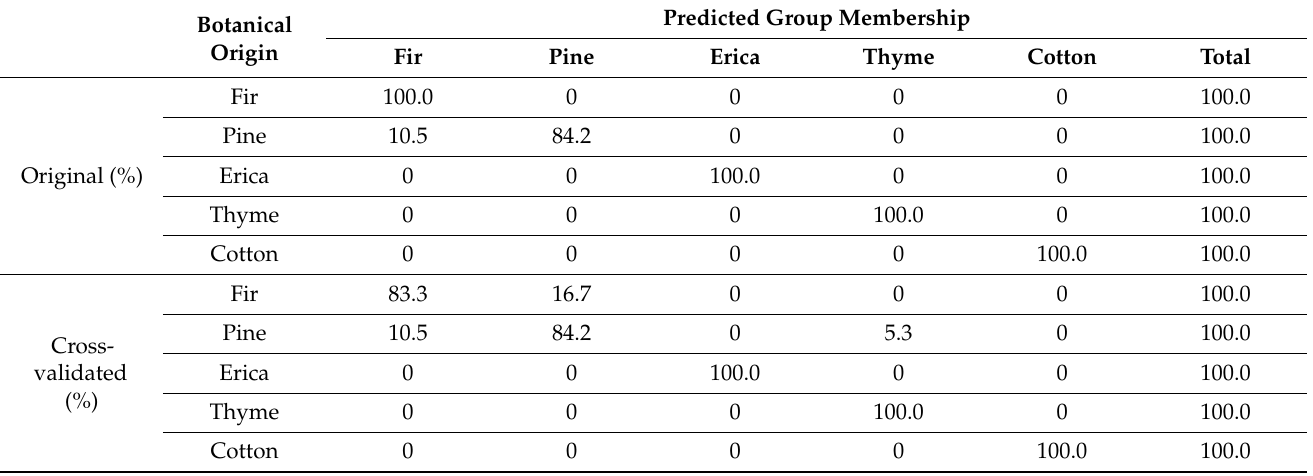
Table 3. Classification results (original and cross-validated) extracted from the prediction model after applying SLDA analysis.